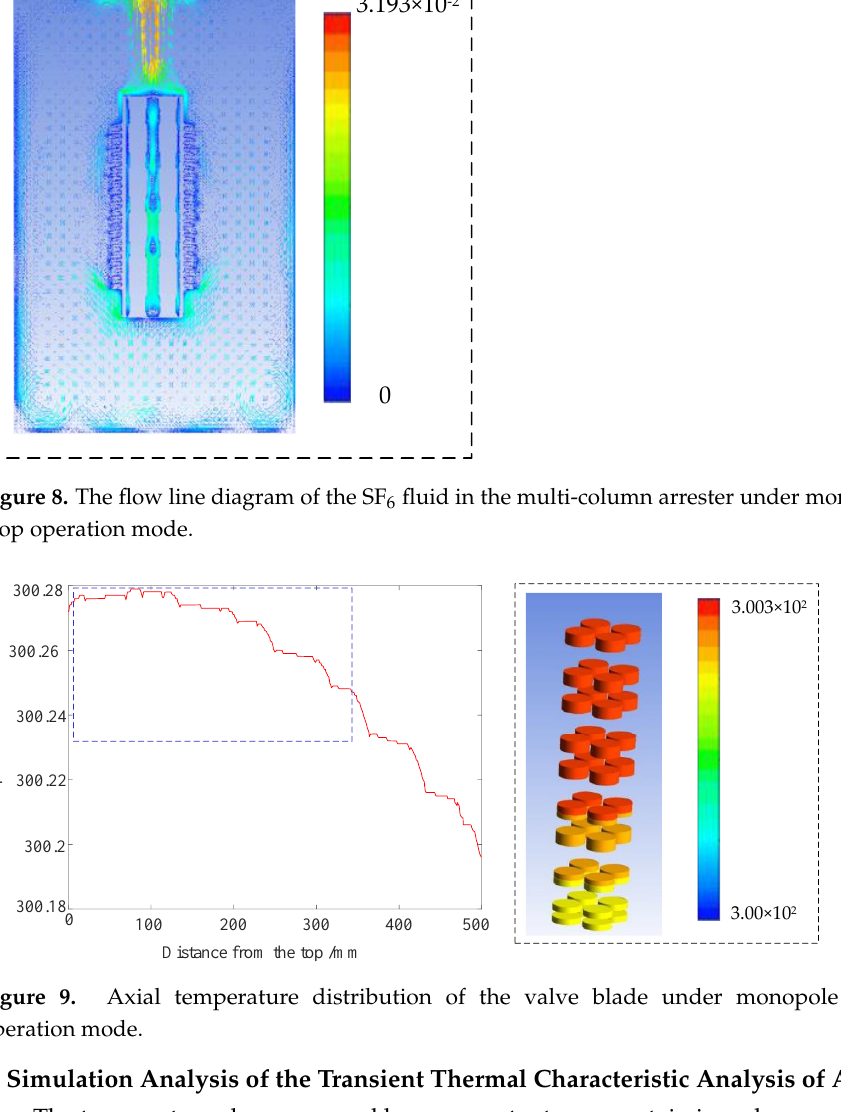
Figure 9. Axial temperature distribution of the valve blade under monopole earth loop operation mode.